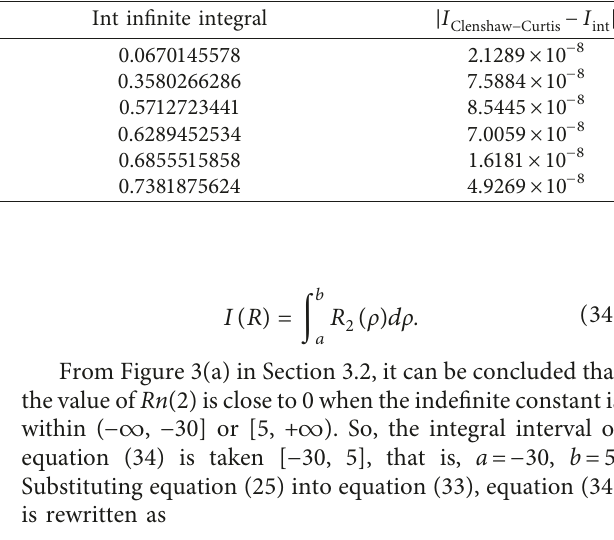
Table 4: Comparison of Clenshaw–Curtis integral and int integral function